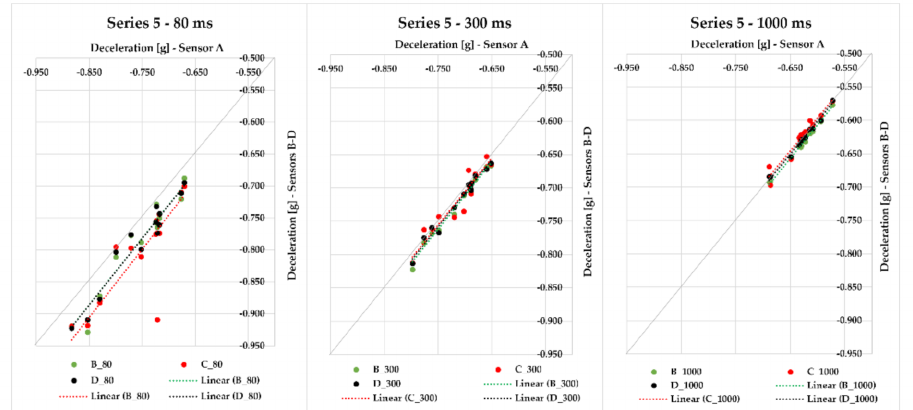
Figure 11. Series 5-Point dependency of individual MEMS sensors against sensor